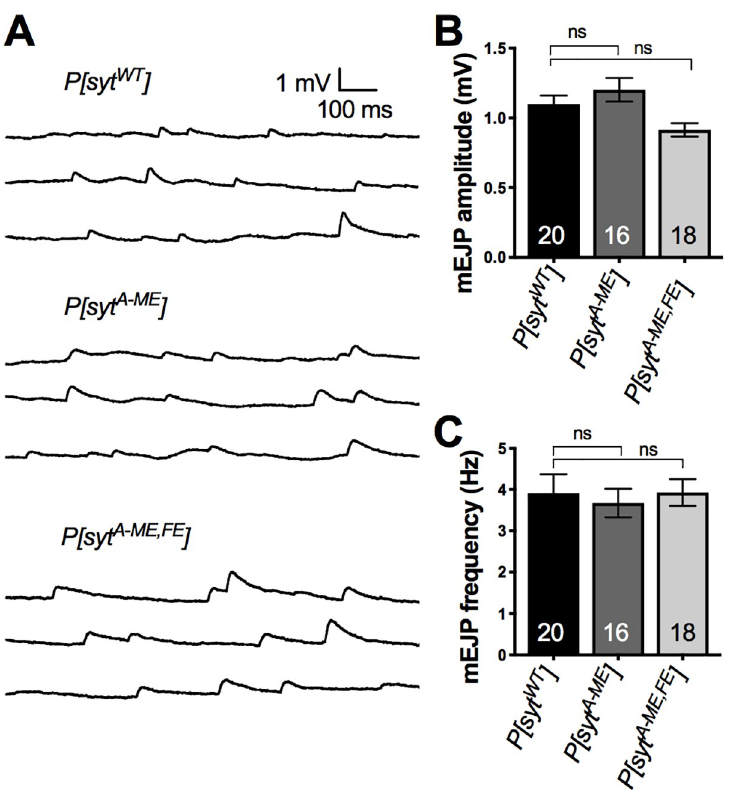
Fig 4. Spontaneous events are unaffected by hydrophobic mutations. A, Representative traces of mEJPs for P [syt WT ] , P[syt A-ME ] , and P[syt A-ME , FE ] . B, Mean mEJP amplitudes ± SEM (Kruskal Wallis test with Dunn’s multiple comparison test, no significance = ns). C, Mean mEJP frequency ± SEM (Kruskal Wallis test with Dunn’s multiple comparison test, no significance =